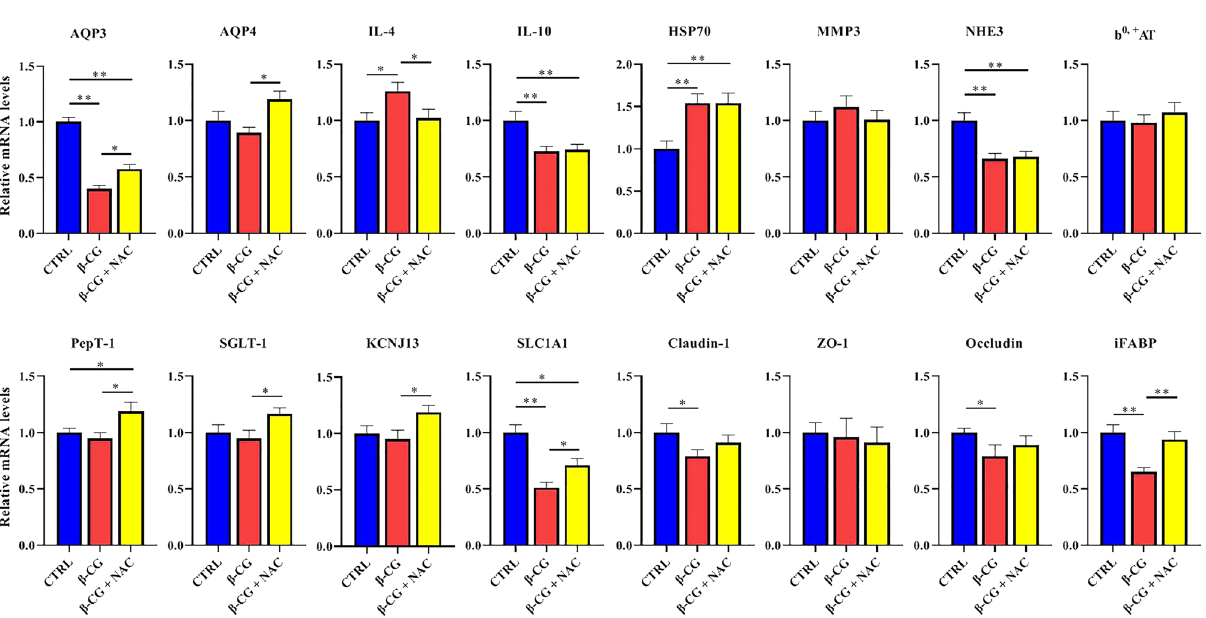
Figure 6. mRNA levels of genes in the jejunum of piglets. Total RNA was extracted from the jejunal mucosa and was analyzed for mRNA levels of genes by real-time RT-PCR with the use of specific primers. RPL4 was used as an internal control. All mRNA levels in the control group were regarded as 1. Data are means ± SEM, n = 8. * P < 0.05, ** P <